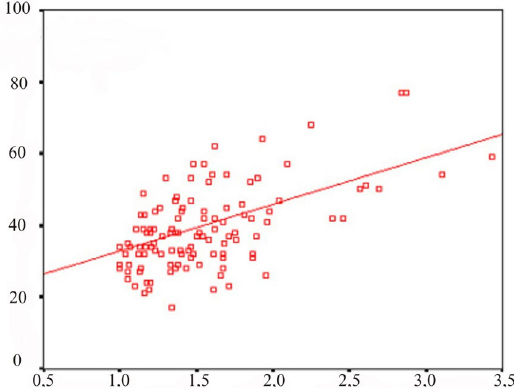
Figure 3. Scatter plot. The ordinate is the psychopathy scale (points) and the abscissa is the SCL-90-R symptomatic distress index (points).